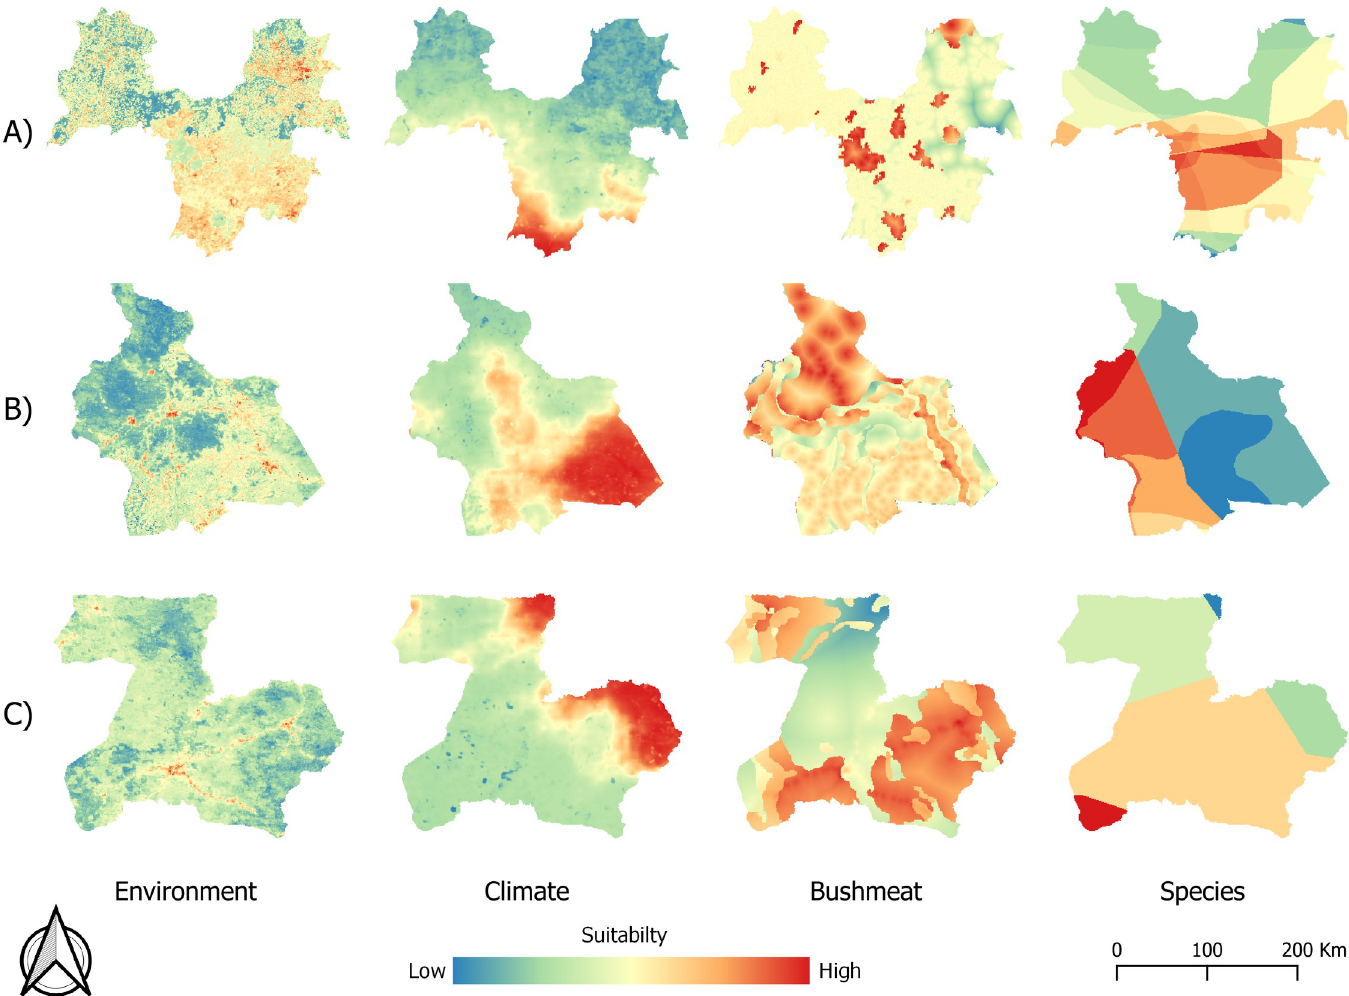
Fig 3. Maps for the four categories of risk factors in study areas in A) Guinea (December 2013), B) Congo (December 2001) and C) Gabon (August2001) (dataset available at